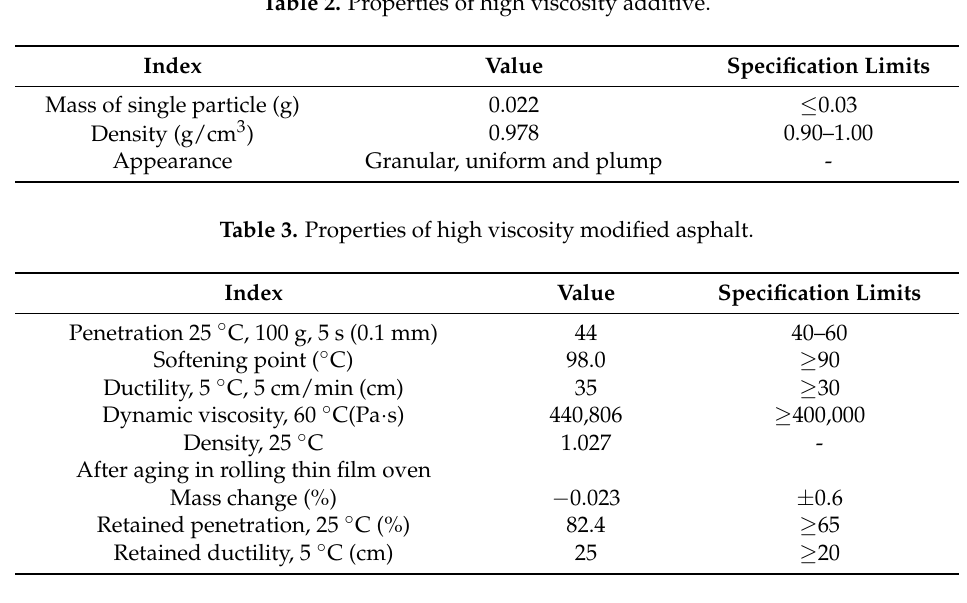
Table 2. Properties of high viscosity additive.